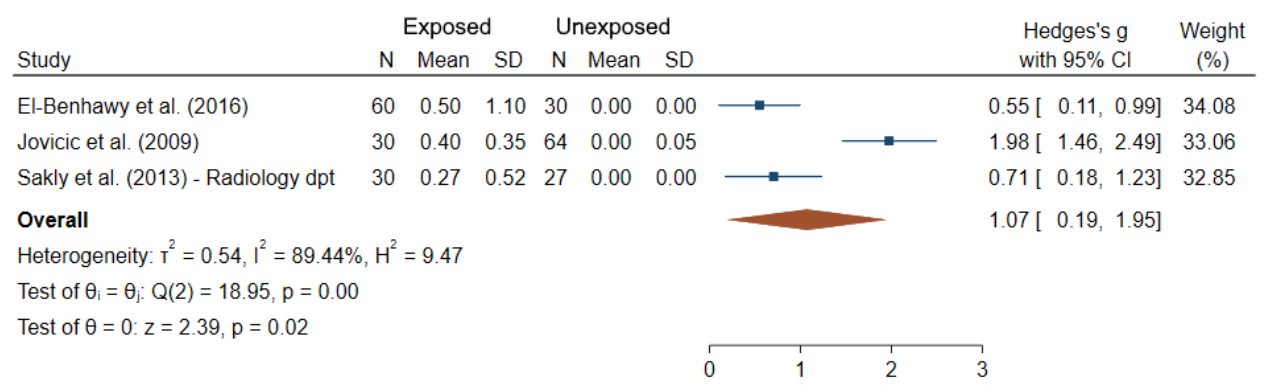
Figure 4. Forest plot of mean differences in dicentrics between IR exposed and unexposed workers.